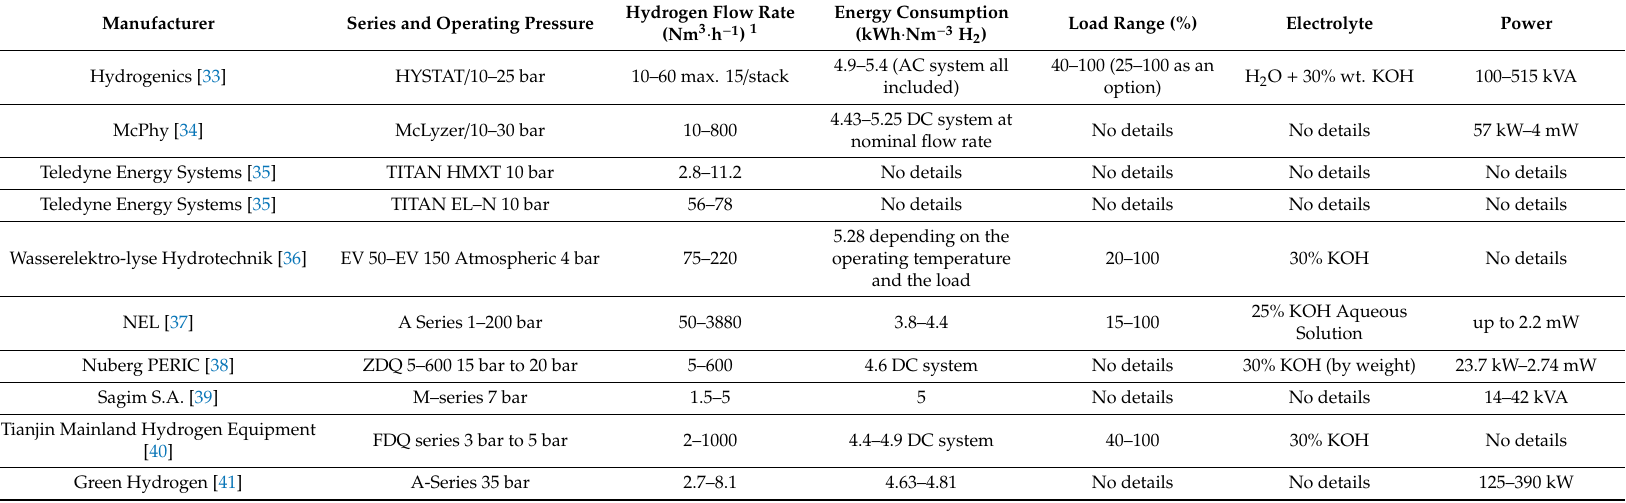
Table 2. Summary of leading manufacturers of alkaline